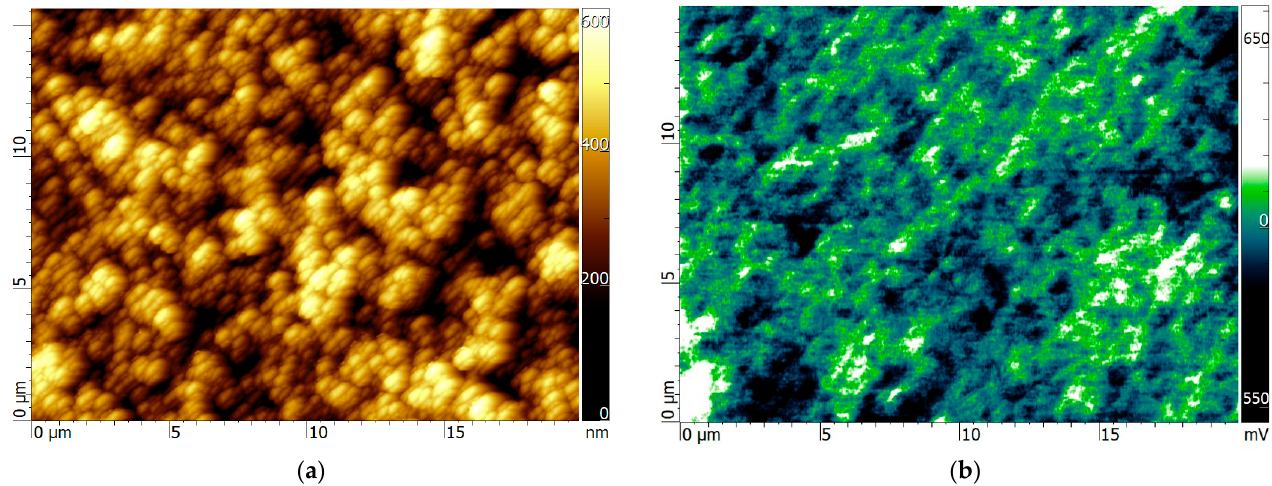
Figure 5. Surface potential maps of black diamond laser induced periodic surface nanostructures and their role as electron traps. ( a ) AFM image of the surface; ( b ) SKPM surface potential images.